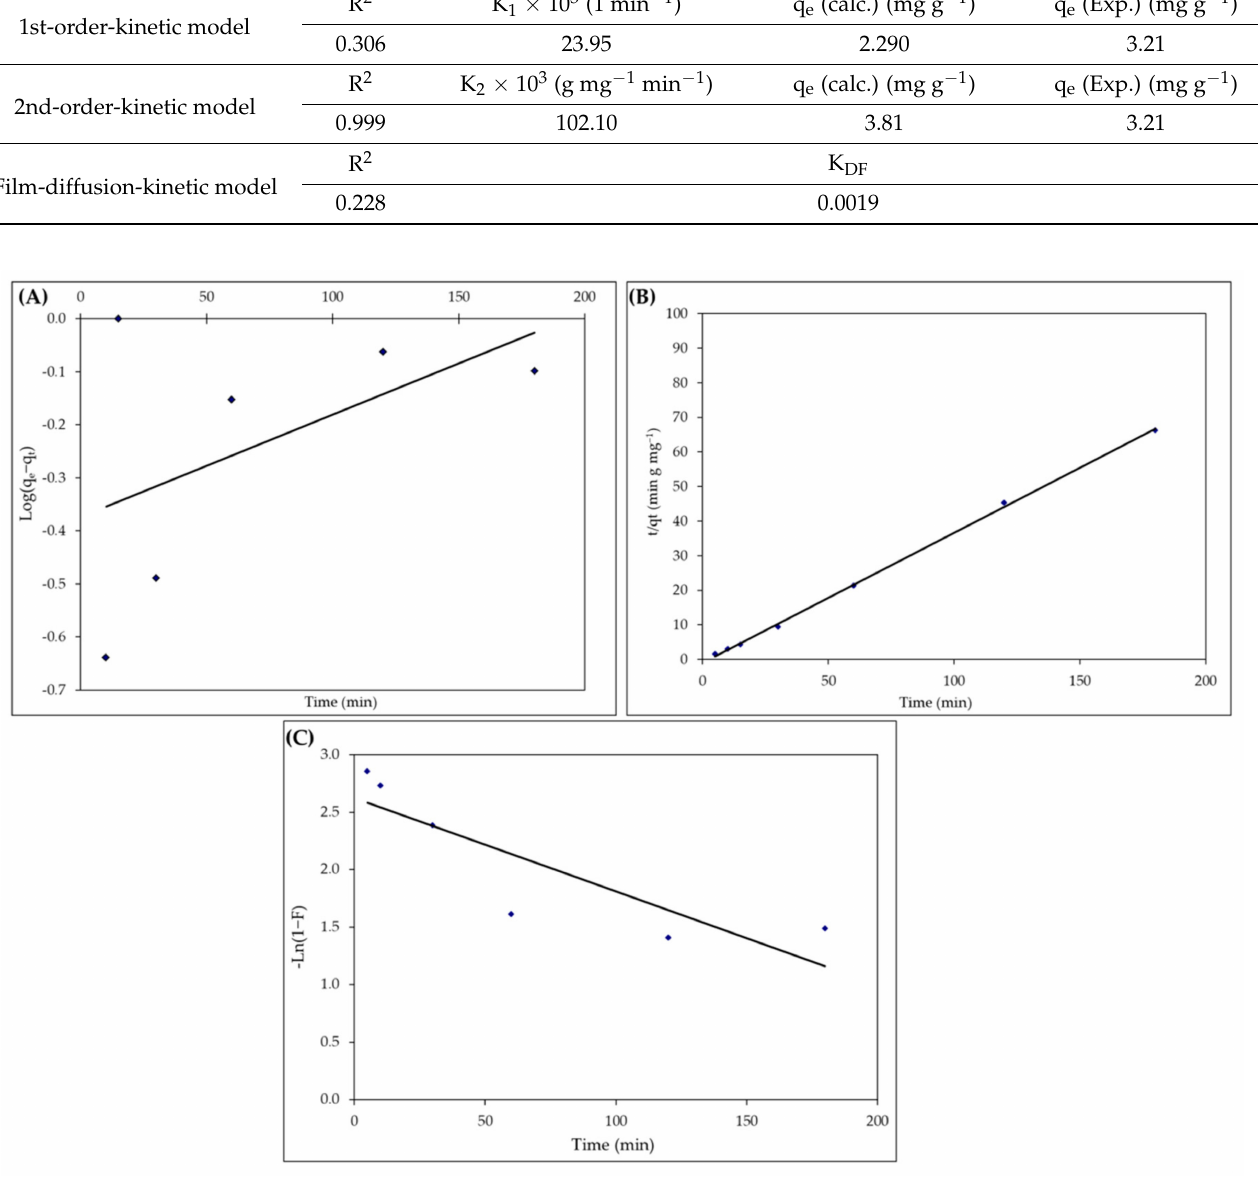
Figure 11. Pseudo-first-order ( A ), pseudo-second-order ( B ), and film-diffusion-kinetic ( C ) kinetics models for IV2R